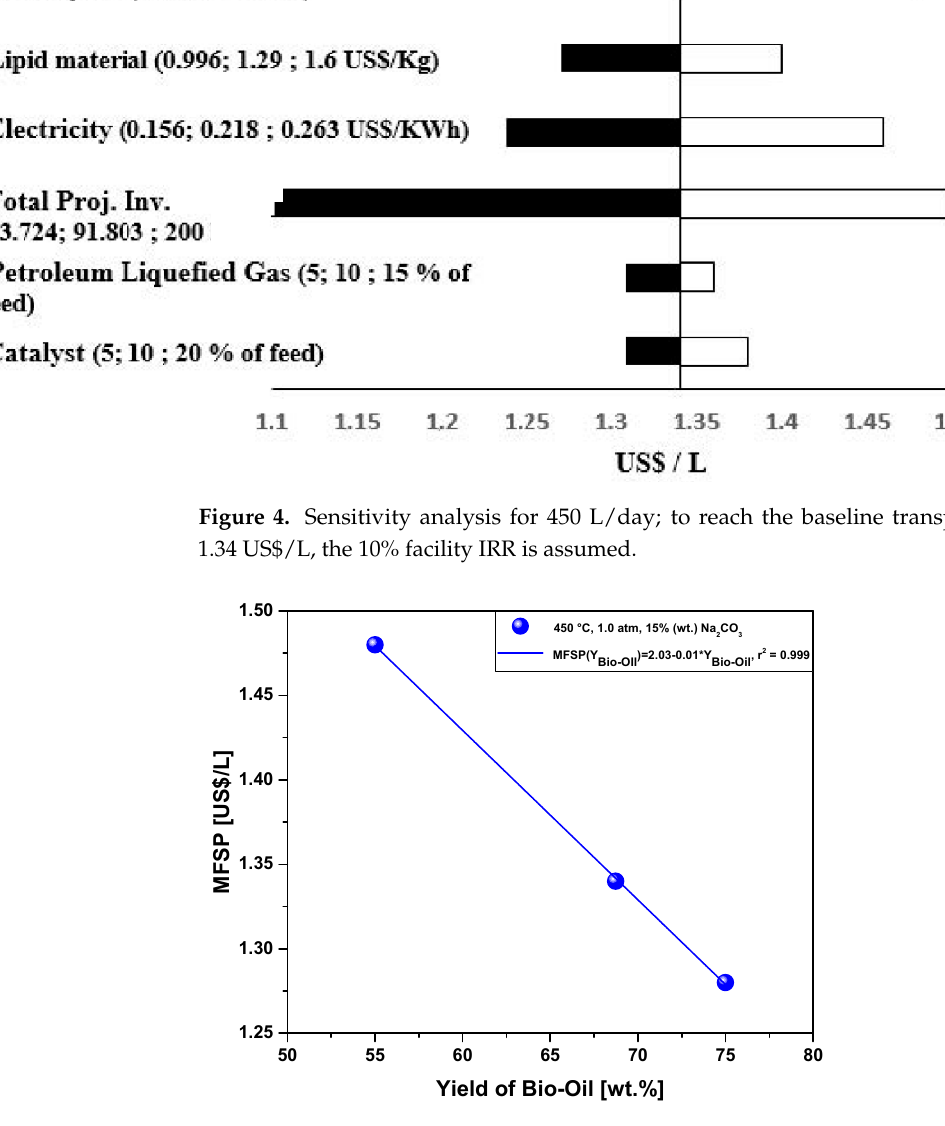
Figure 5. MFSP as a function of bio-oil yield by sensitivity analysis for a 450 L/day production.